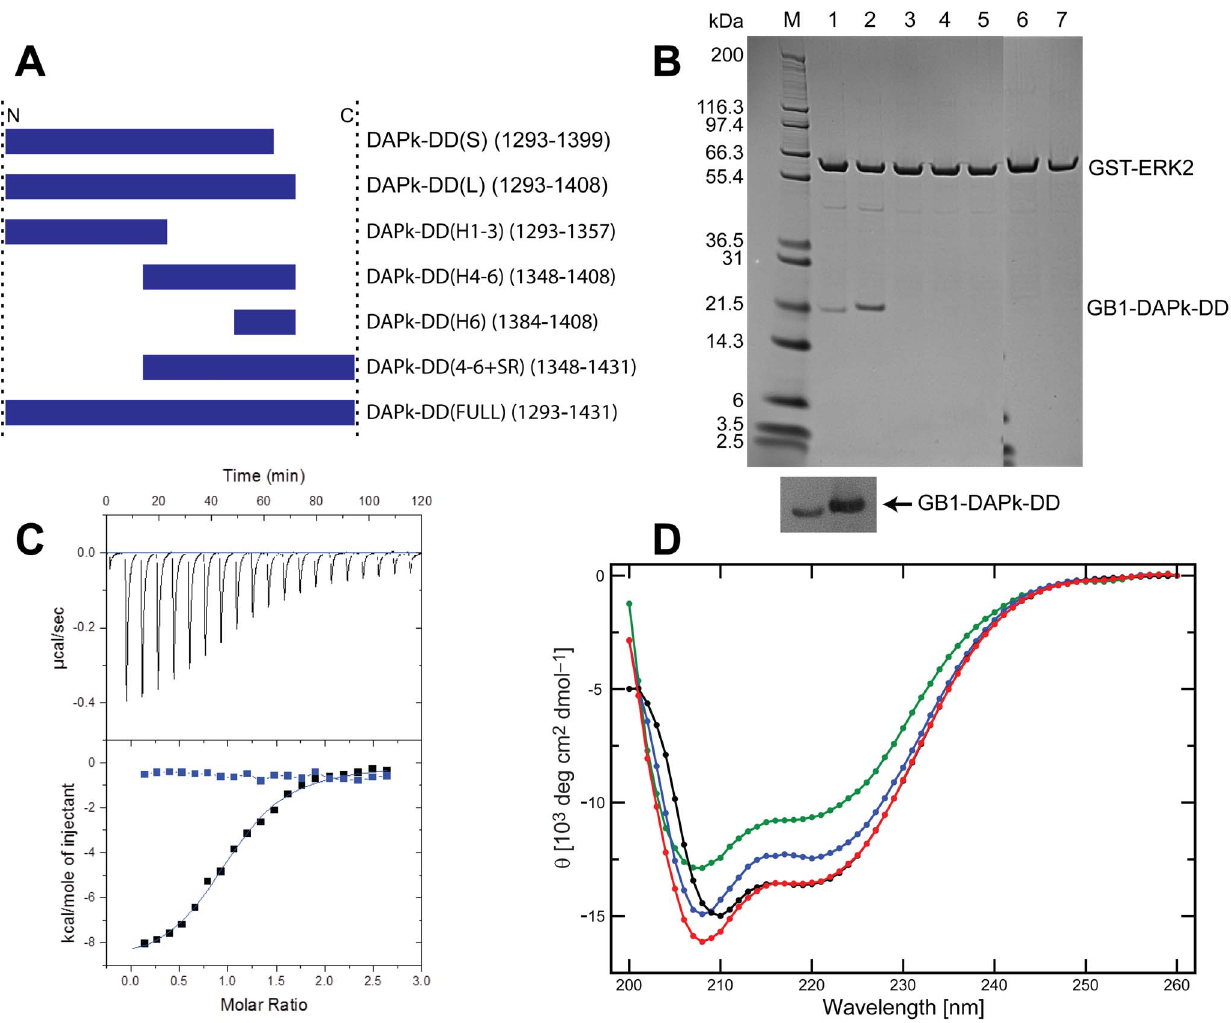
Figure 5. The DAPk-DD interacts with ERK2 and the interaction does not lead to any significant change in the secondary structure of the DAPk-DD. (A) Schematic illustrating the various DAPk-DD peptides used for the ERK2 binding study. (B) LDS-PAGE analysis of the GST pull- down assay showing eluates of GST-ERK2 bound glutathione beads after being incubated with the various GB1-DAPk-DD constructs shown in (A). Lane M, molecular weight size markers (kDa); Lane 1, GB1-DAPk-DD(S); Lane 2, GB1-DAPk-DD(L); Lane 3, GB1-DAPk(H1-3); Lane 4, GB1-DAPk(H4-6); Lane 5, GB1-DAPk(H6); Lane 6, GB1-DAPk(H4-6 + SR); Lane 7, GB1-DAPk-DD + SR. Anti-His6 Western blot of the eluates shown in the LDS-PAGE for the short and long GB1-DAPk-DD constructs are shown below the LDS-PAGE. (C) ITC data of GB1-DAPK-DD(L) injected into a solution of ERK2. The upper box shows heat liberated following 19 equal volume injections of GB1-DAPk-DD(L) into 15 m M of ERK2 at 25 u C. The integrated heats (lower box) are shown as examples of data quality. The continuous lines represent an optimal fit. For these data, the optimal fit for the DD gives an observed K d of 0.92 m M with an observed D H of 2 38.43 kJ/mol. The blue symbols represent the heat of dilution of the control experiment. (D) CD analysis of the ERK-2-DAPk-DD complex. Far-UV CD spectra of ERK2 (blue circles) and GB1-corrected DAPk-DD(L) (green circles) are presented. The signal for the equimolar complex of GB1-DAPk-DD(L) and ERK2 was recorded (black circles), from which the ellipticity of GB1 was subtracted to give the native DAPk-DD-ERK2 CD signal. By combining the individual ERK2 and DAPK-DD CD data (red circles) a very similar CD profile was obtained to that observed for the complex, indicating minor changes in secondary structure to either protein upon formation of a complex. In particular, the signature a -helix wavelength, 222 nm, showed negligible differences. The y-axis represents mean reside ellipticity values and data collection were terminated at 195 nm because of the high tension voltage (dynode) registered at lower wavelengths. The inset represents the data over the wavelength range of 200 2 230